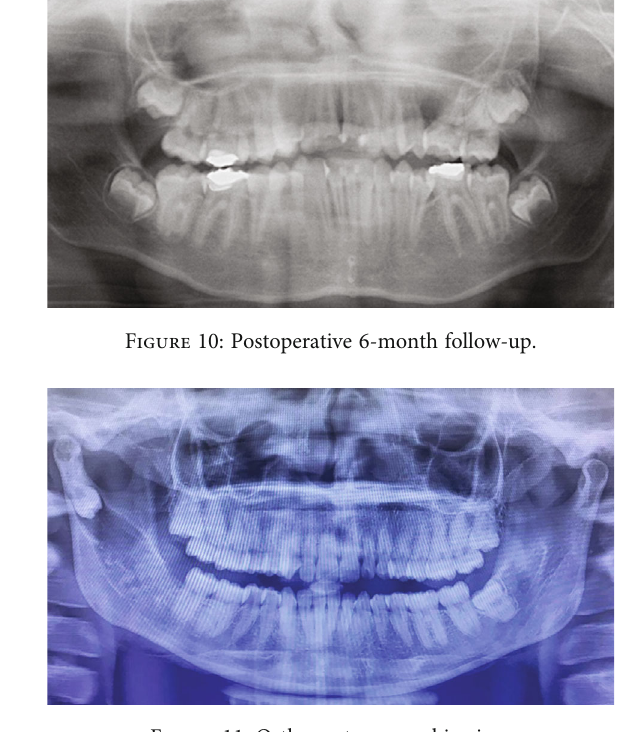
Figure 11: Orthopantomographic view.